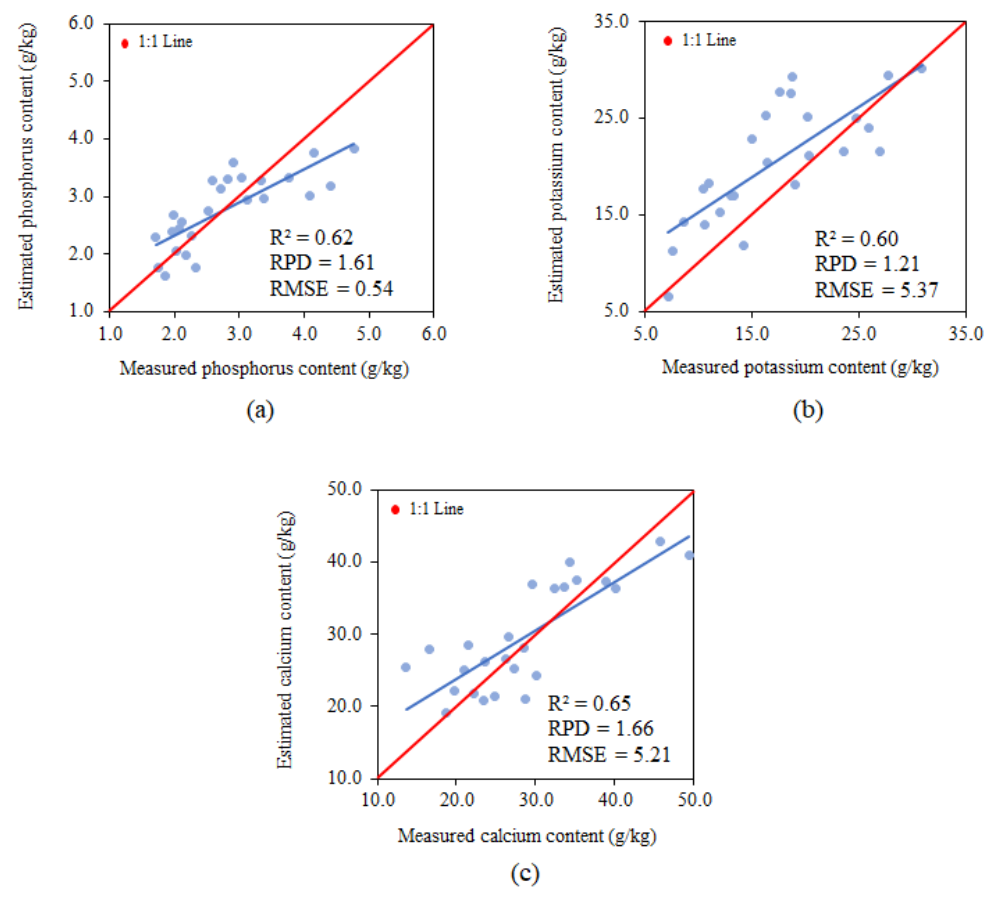
Figure 8. Relationships between the measured and estimated P ( a ), K ( b ) and Ca ( c ) content, using the single-band model.